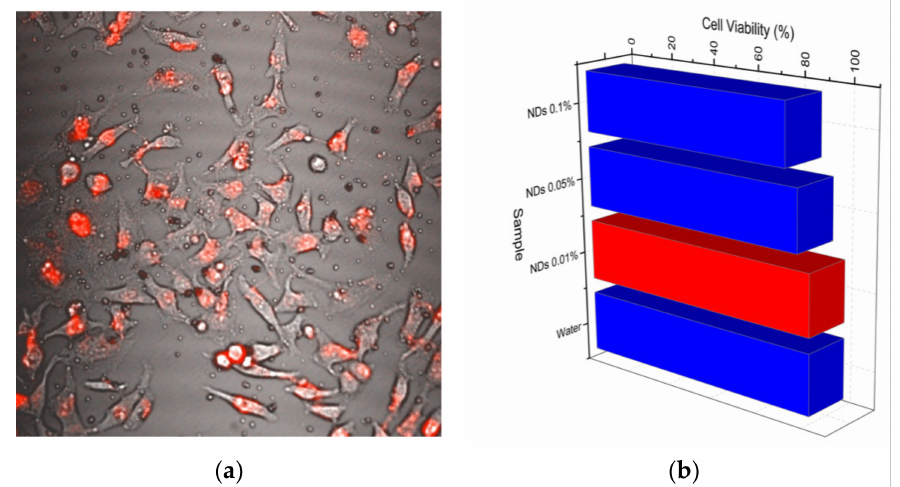
Figure 3. ( a ) Fluorescence of 100 nm HPHT FNDs in HeLa cells. The fluorescence image was recorded around the membrane after 24 h of incubation at 37 ◦ C. ( b ) MTT Cytotoxicity assay of different concentrations of 100 nm HPHT FNDs in HeLa cells, the red bar corresponds to the concentration used in ( a